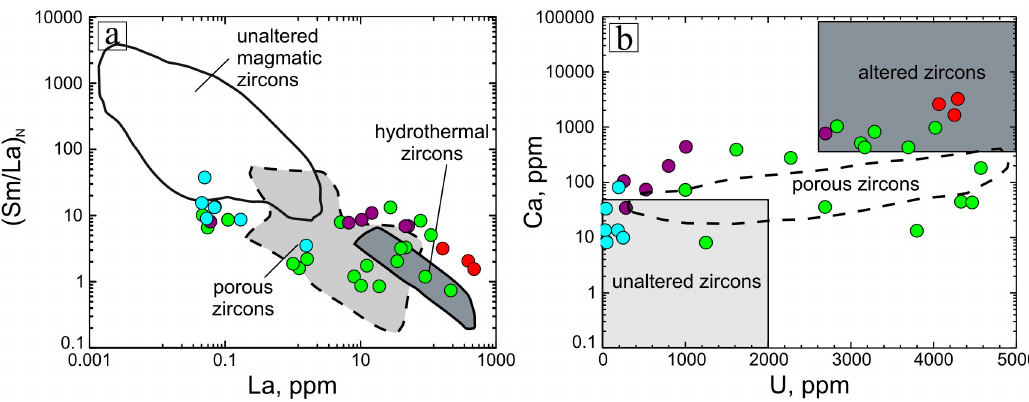
Figure 9. ( a , b ) Co-variation diagrams showing the composition of the studied zircons. Fields in ( a ) are after [ 56 – 58 ] and in ( b ) after [ 58 , 59 ]. Symbols are the same as in Figure 8.